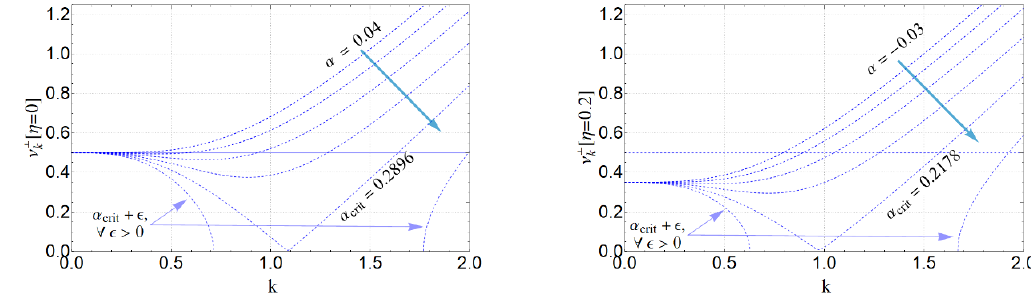
intersects the (cid:23) ? = 1 = 2 line only once, indicating the presence of a k k